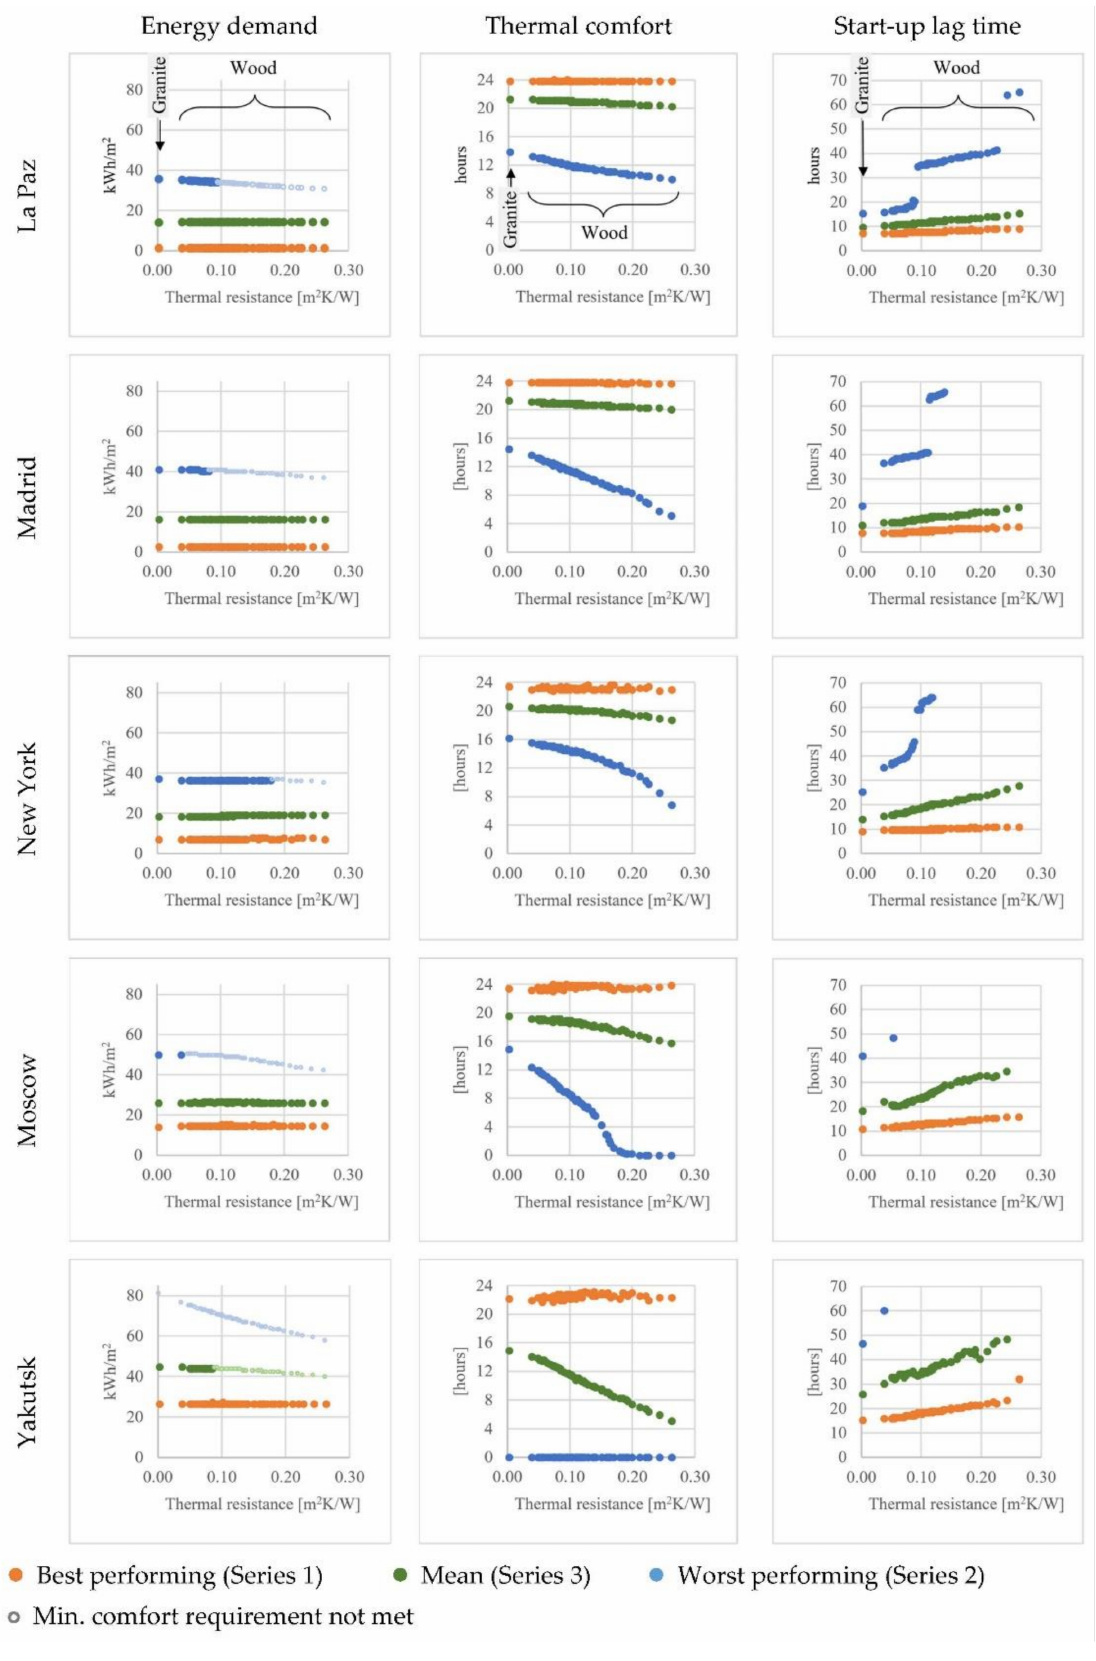
Figure 11. Effect of thermal resistance of wooden flooring on energy demand, thermal comfort, and start-up lag time in five representative